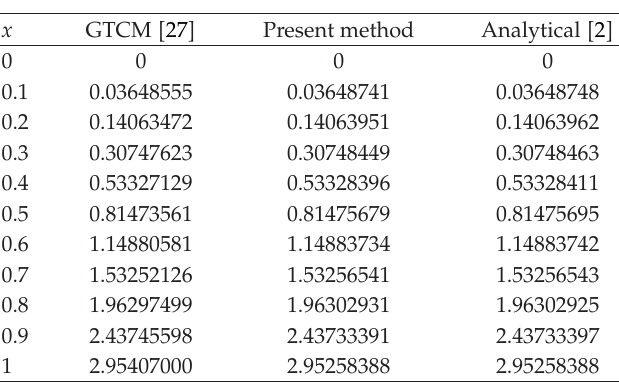
Table 2: Comparison of solutions for Example 3.1, Case